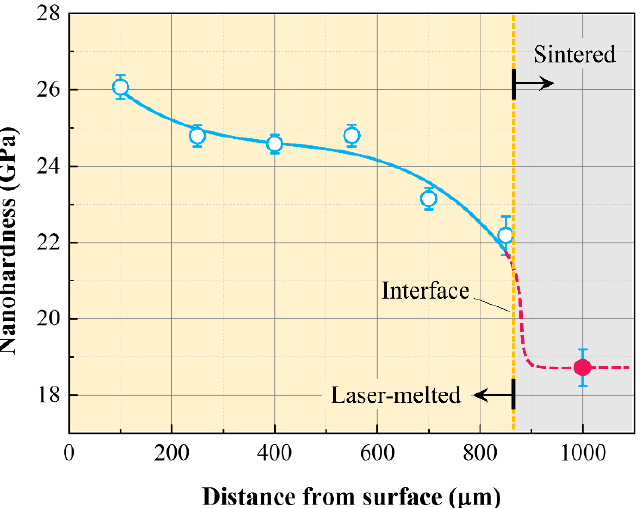
Figure 11. Nanohardness distribution of the nanostructured Al 2 O 3 -YSZ eutectic layer induced by the rapid laser remelting process as a function of the distance from the surface. Reproduced with permission from Reference [66], Copyright © 2019 Elsevier Ltd. and Techna Group S.r.l.